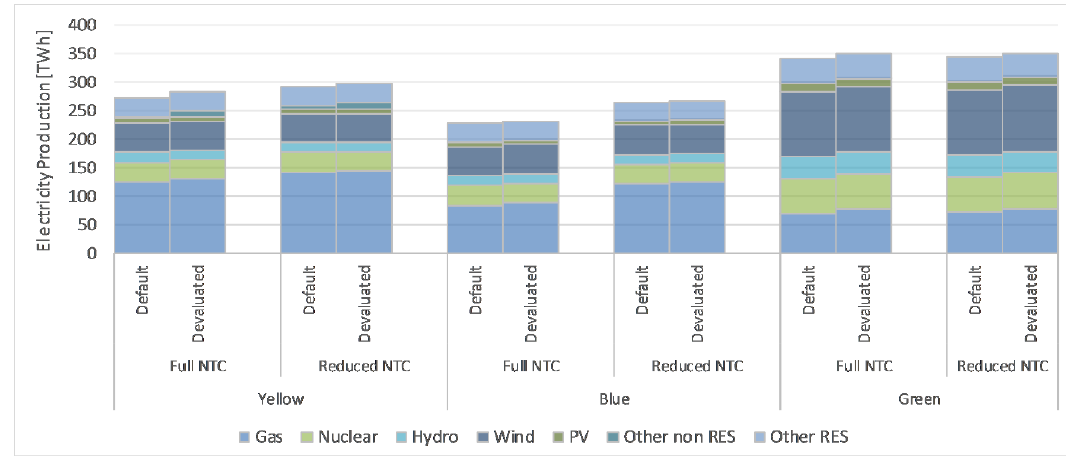
Figure 2. 2030 Power mix across scenarios and variants. Source: Own calculation.